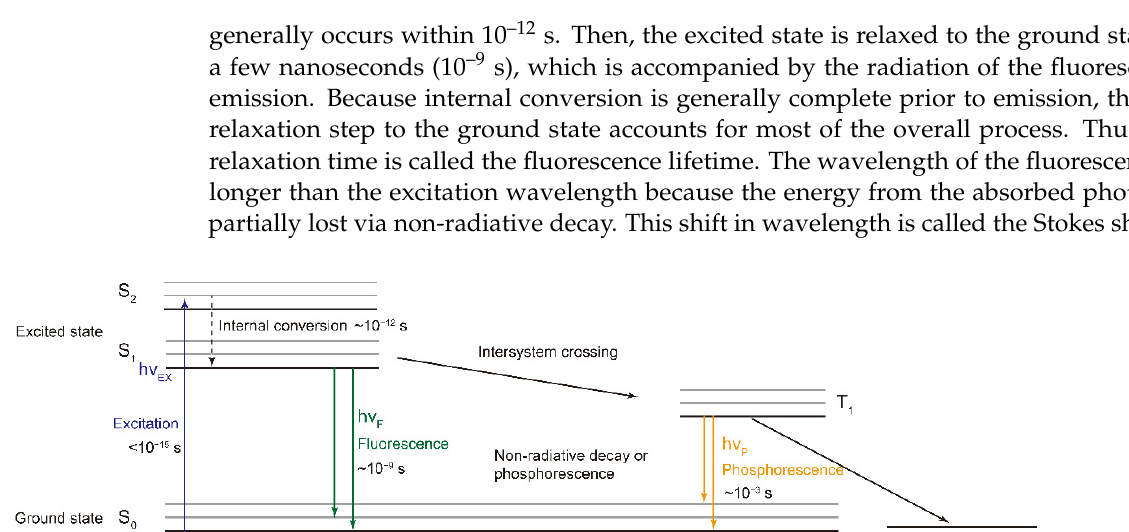
Table 1. Characteristics of fluorophores commonly used in fluorescence microscopy.